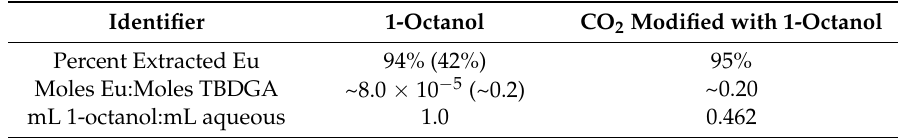
Table 5. Comparison of extraction with TBDGA in 1-octanol to TBDGA in 1-octanol modified CO 2 (l) . In parenthesis the percent extraction at an equal moles TBDGA:Eu as in the CO 2 (l) is